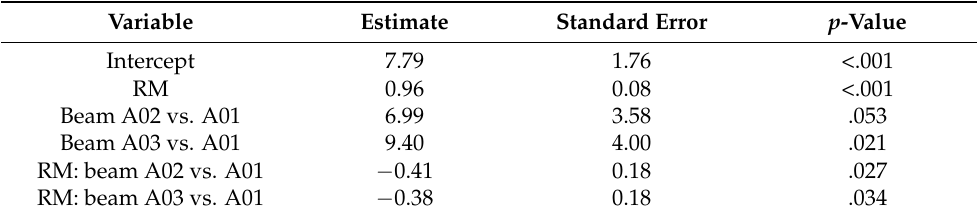
Table 11. Estimates for regression models of FF with RM beam as the predictor and RM*Beam interaction term.